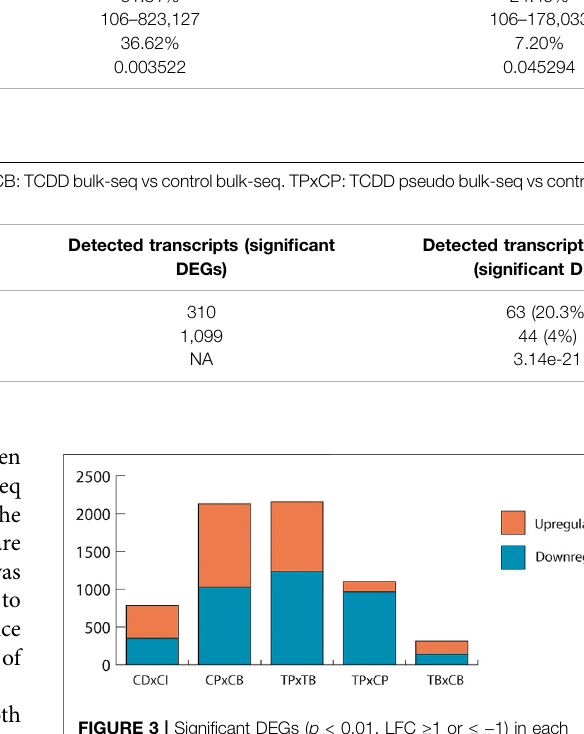
FIGURE 3 | Signi fi cant DEGs ( p < 0.01, LFC ≥ 1 or ≤ − 1) in each comparison. Upregulated: LFC ≥ 1; downregulated: LFC ≤ − 1. CDxCI: paired control samples of dissociated and intact testes used for bulk-seq. CPxCB: paired control samples of dissociated testes used for pseudo bulk-seq and bulk-seq. TPxTB: paired TCDD-exposed samples of dissociated testes used for pseudo bulk-seq and bulk-seq. TPxCP: pseudo bulk-seq analysis of paired dissociated control and TCDD-exposed testes. TBxCB: bulk-seq analysis of paired dissociated control and TCDD-exposed